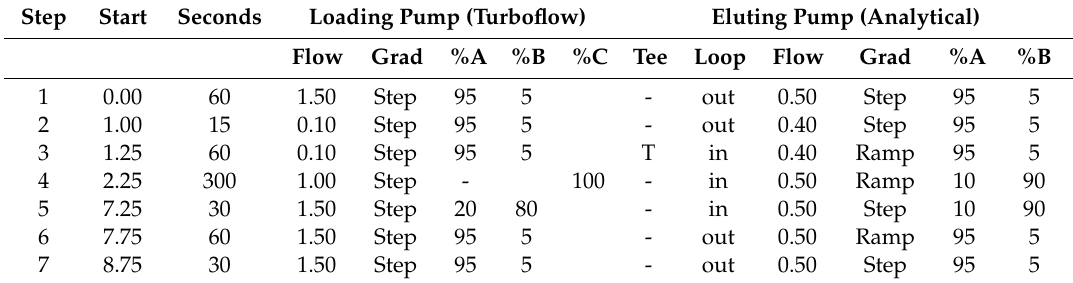
Table A1. Turboflow and Chromatography Conditions.